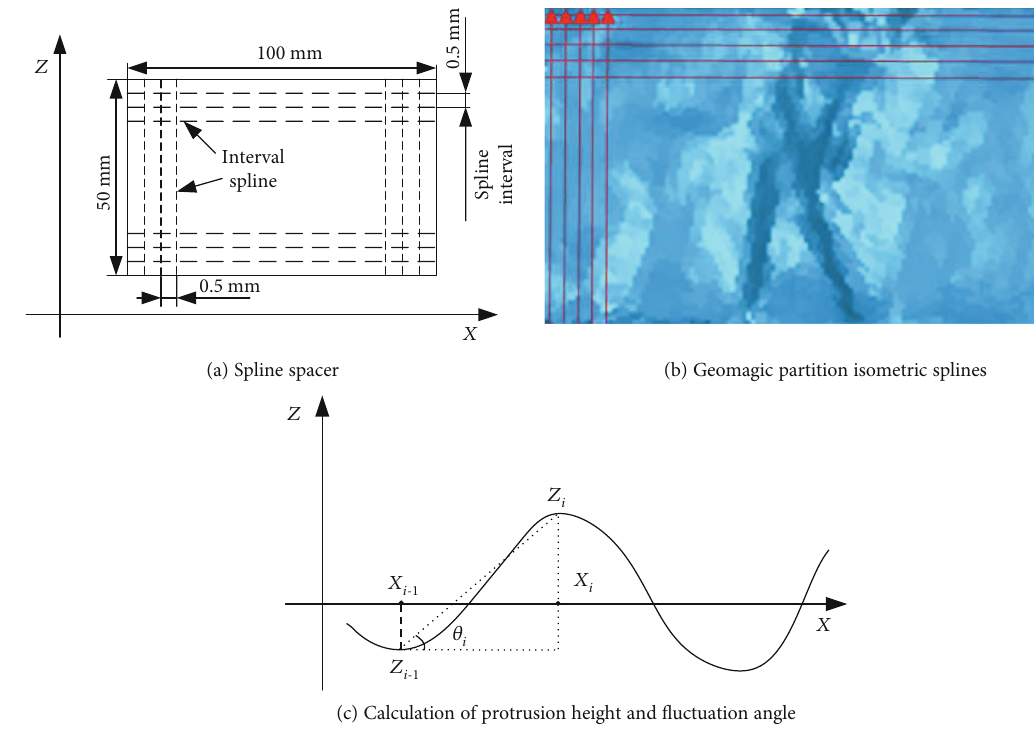
Figure 4: Spline interval and calculation of Geomagic.